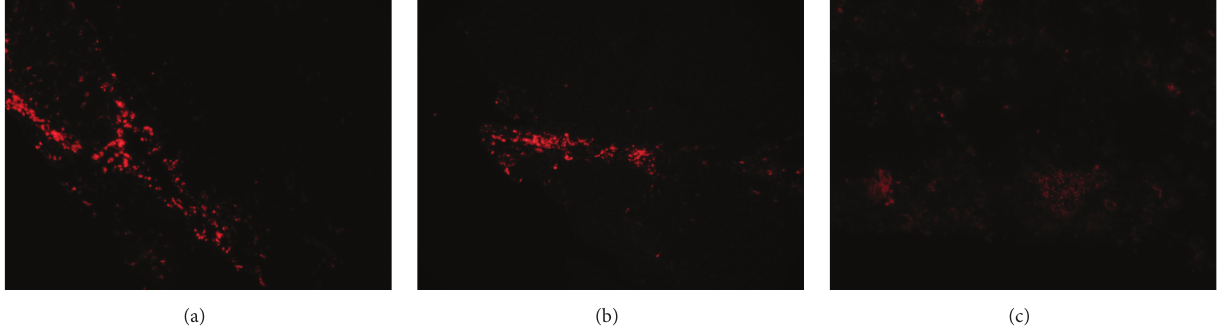
Figure 3: Distribution and migration of CM-Dil labeled ASCs. (a) ASCs distributed along the needle passage at 1w after implantation; (b) ASCs distributed diffusely in the skeletal muscle tissue at 4w after implantation; (c) the distribution of ASCs became more diffuse accompanied by the attenuated fluorescence intensity at 8 w after implantation. The images were observed under a magnification of 200x.